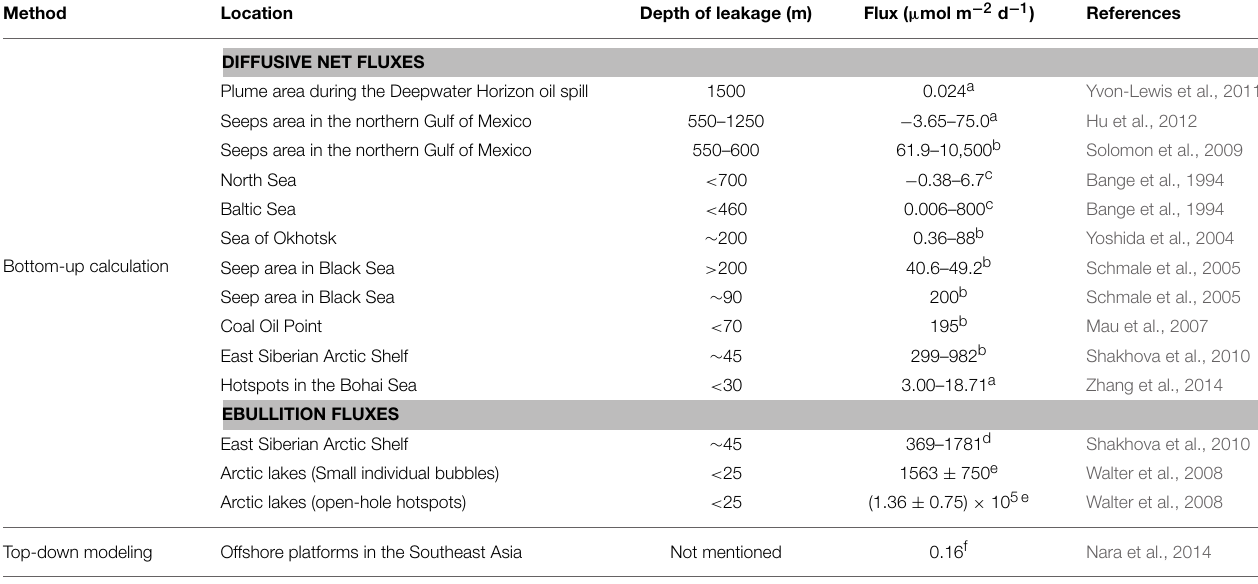
TABLE 1 | Sea-to-air CH 4 fluxes from marine environments affected by oil-gas exploration and methane hydrate dissociation.